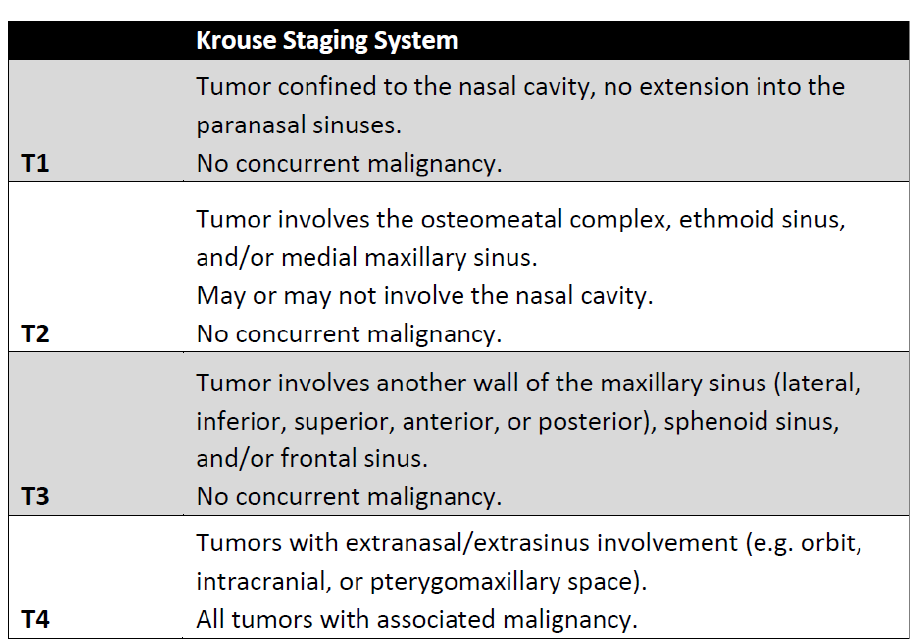
Figure 6. Krouse staging system [20].